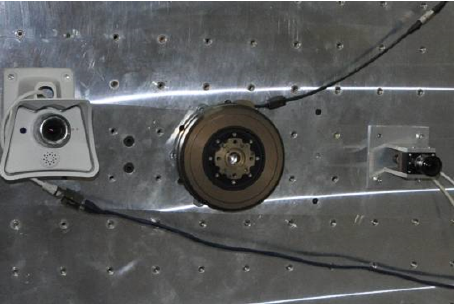
Figure 21: Force/Torque sensor mounted on a robot’s Tooling Adapter Plate at